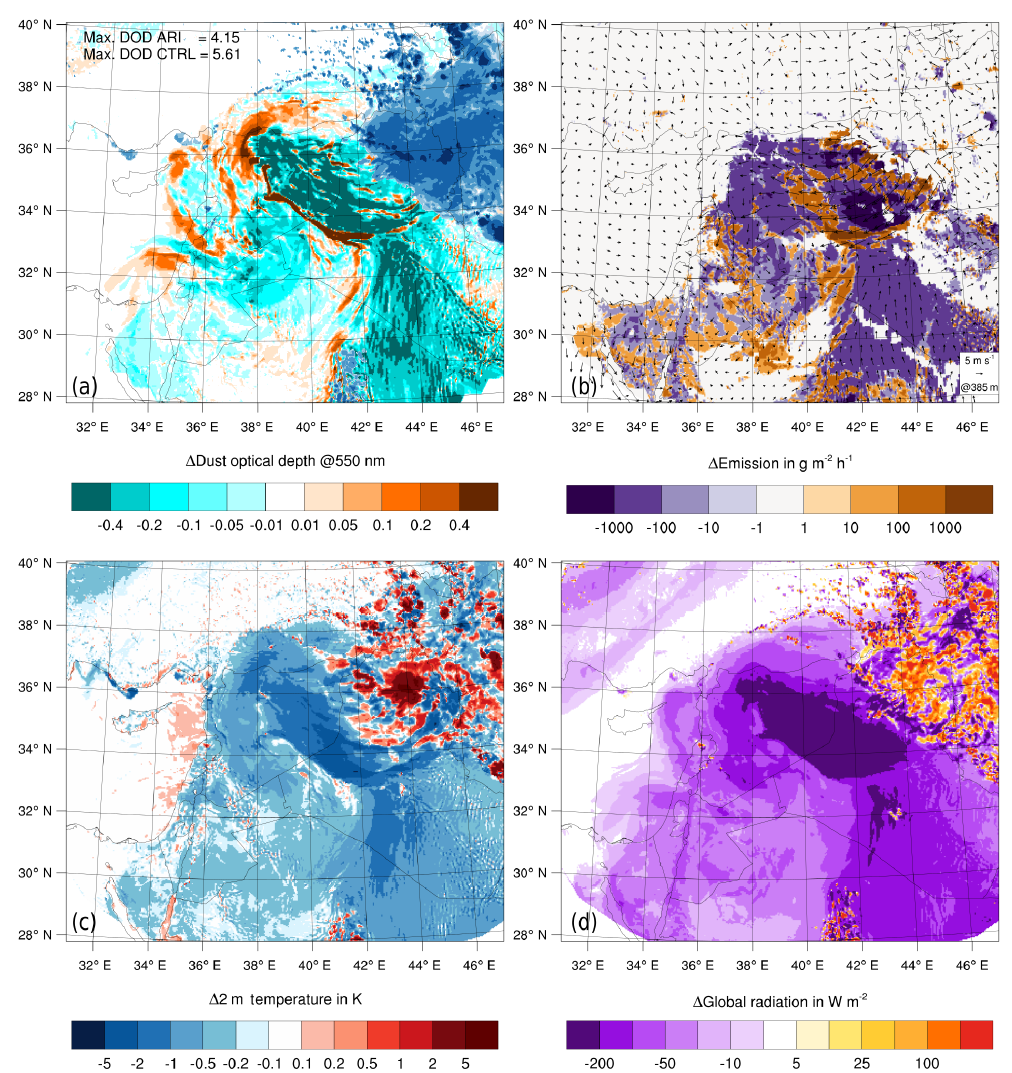
Figure 13. ICON-ART model results at 10:00UTC, 7 September; layout and colour-coding as in Fig.